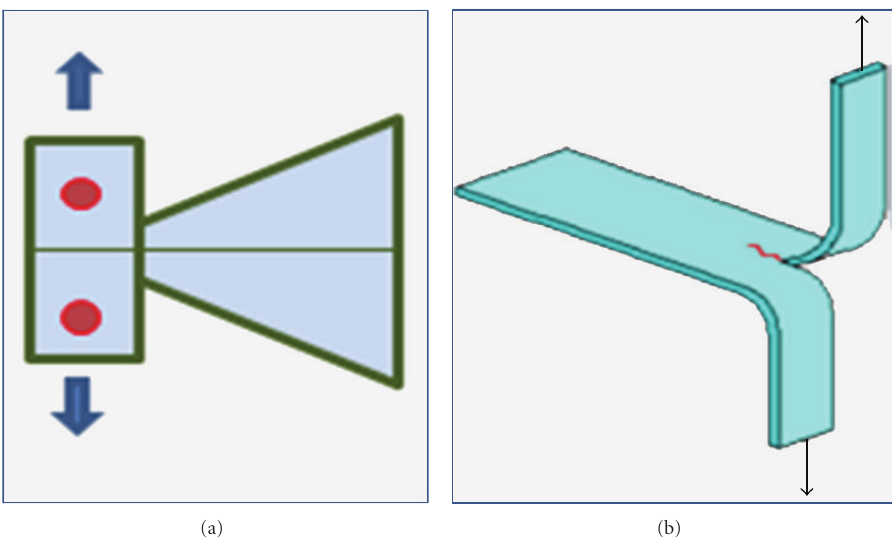
Figure 2: (a) Schematic of the TDCB-based fracture toughness and (b) tear protocols to evaluate healing